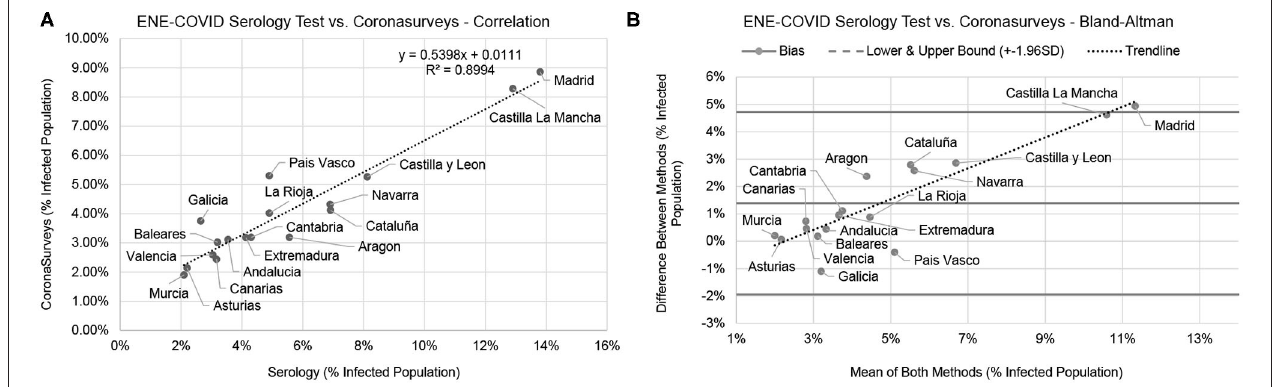
FIGURE 1 | Comparison between the serology test and CoronaSurveys, direct correlation (A) , and Bland-Altman (B) .